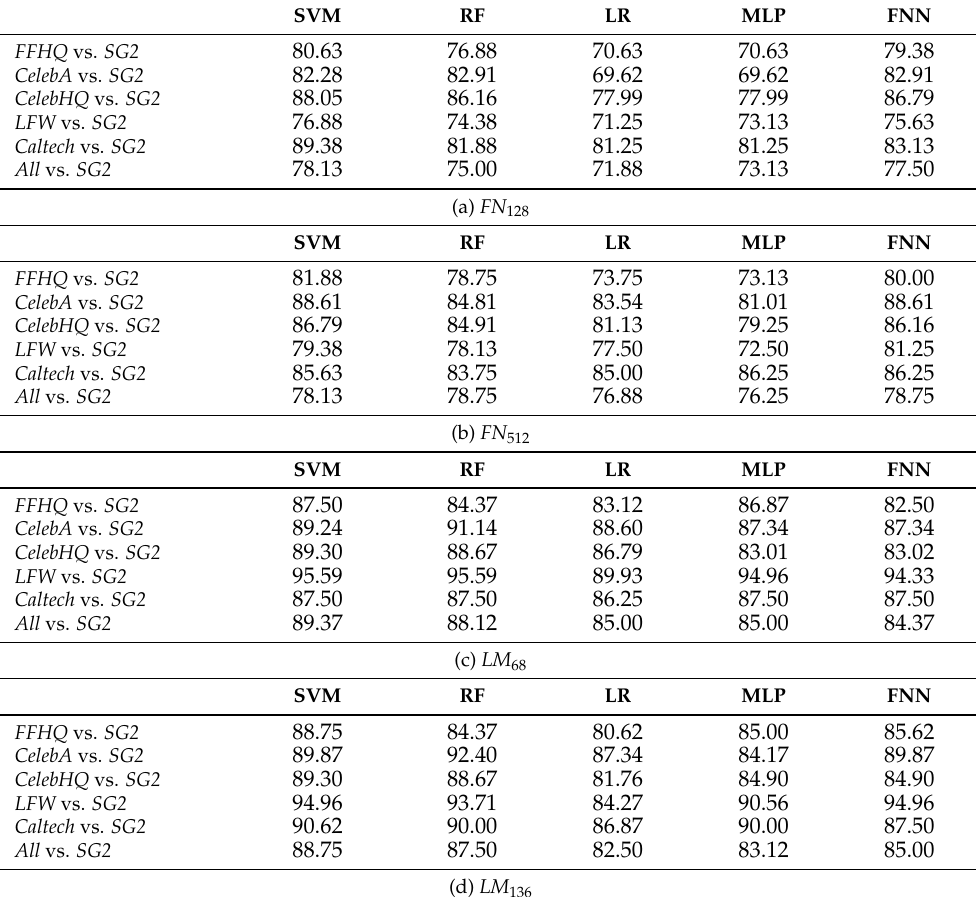
Table 2. Accuracy obtained with different data and classifiers (reported in percentage). SVM RF LR MLP FFHQ vs. SG2